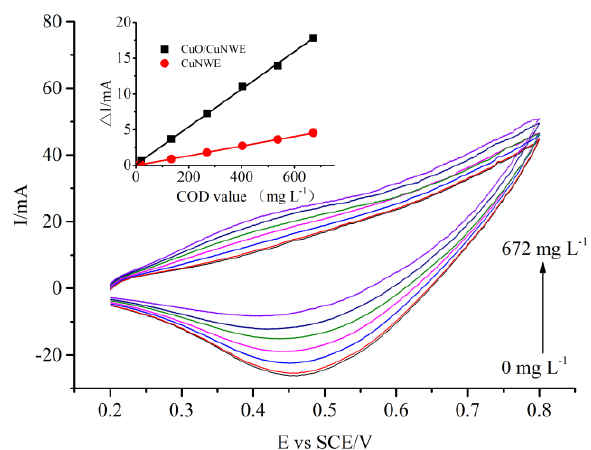
Figure 5. CV curves recorded at the CuO/CuNWE in a 0.075 M NaOH solution with various COD values (0 mg L − 1 , 19.2 mg L − 1 , 134.4 mg L − 1 , 268.8 mg L − 1 , 403.2mg L − 1 , 537.6mg L − 1 and 672 mg L − 1 ) at